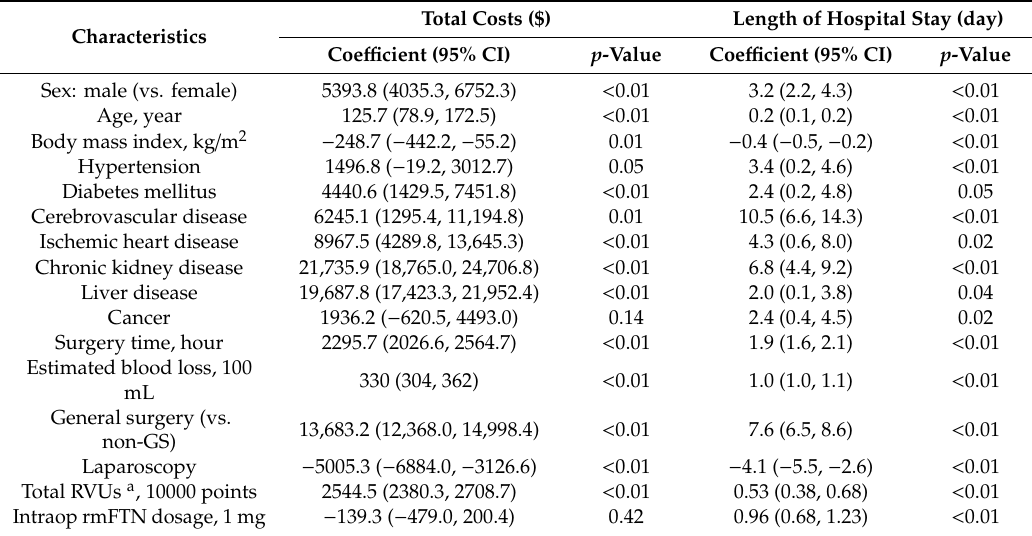
Table 2. Univariable linear regression analysis for total costs ($) and length of hospital stay (day) after major abdominal surgery.